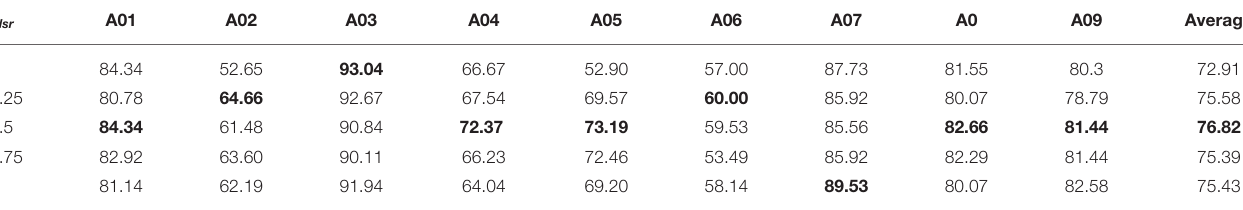
TABLE 6 | Classification accuracies (%) of models with different α lsr values on the BCI competition IV-2a. α lsr